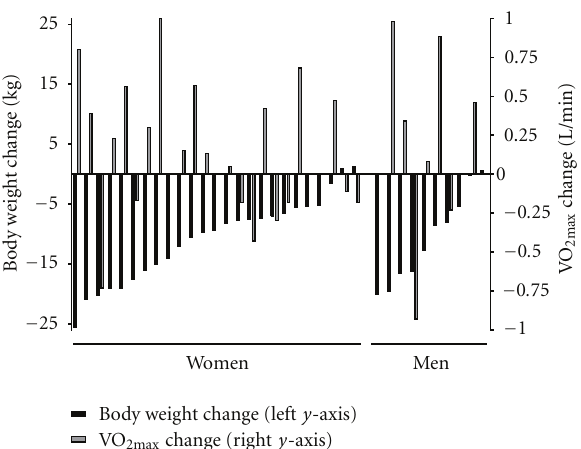
Figure 1: Individual changes in body weight and cardiorespiratory fitness ( n = 22 for women; n = 8 for men). Subjects are sorted within gender with respect to body weight